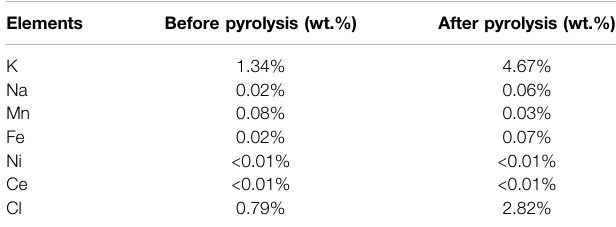
TABLE 4 | Element composition of corn straw before and after